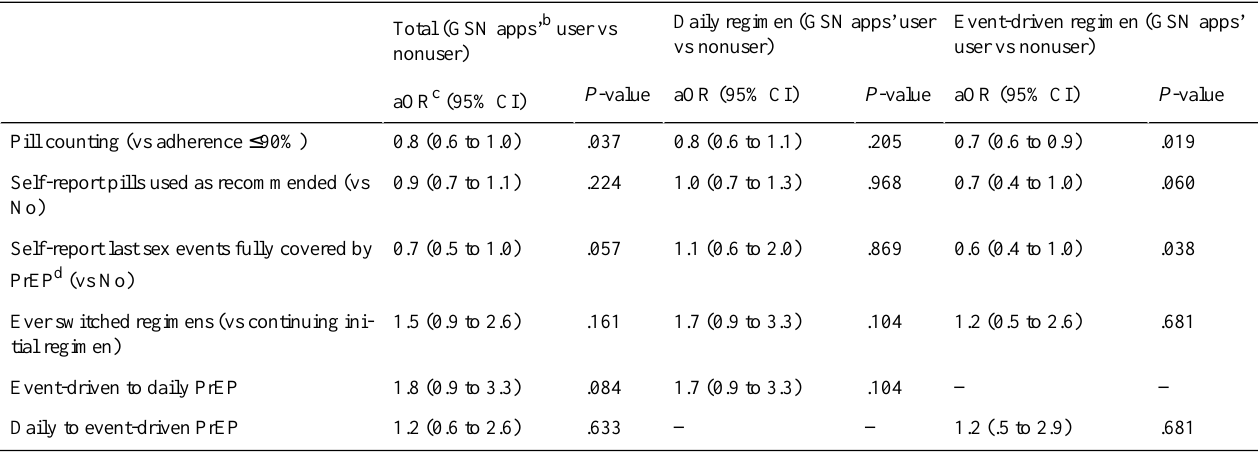
Table 3. Adherence to pre-exposure prophylaxis and change of regimen among men who have sex with men that are geosocial networking app users and nonusers (N=993).